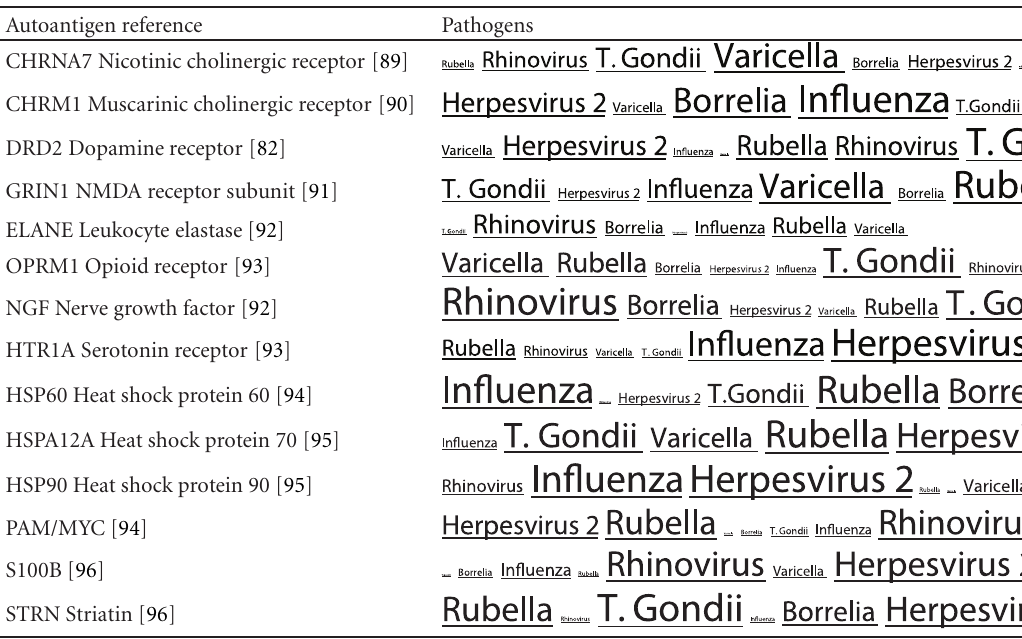
Table 2: Pathogens expressing proteins with homology to the autoantigens reported in schizophrenia. The size of the tags is proportional the number of pathogen’s proteins that are homologous to the autoantigen. Note that the profile is di ff erent for each pathogen. The original BLAST files can be found at